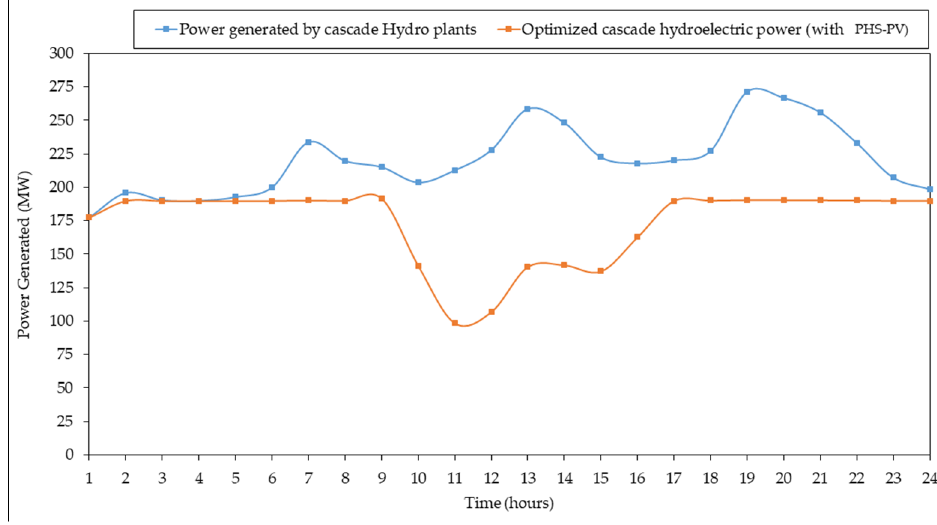
Figure 9. Optimized cascade hydropower output.